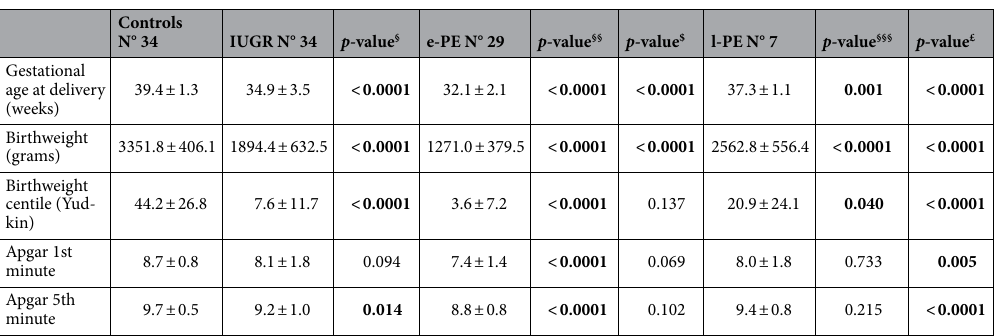
Table 2. Perinatal outcome of the studied pregnancies. § Two-independent sample t -test (IUGR vs. Controls). §§ Two-independent sample t -test (e-PE vs. Controls). $ Two-independent sample t -test (IUGR vs. e-PE). §§§ Two-independent sample t -test (l-PE vs. Controls). £ Anova Test among the four groups (Controls vs. IUGR vs. e-PE vs. l-PE). IUGR Intrauterine Growth Restriction; PE Preeclampsia; e-PE Early-onset PE; l-PE Late- onset PE.